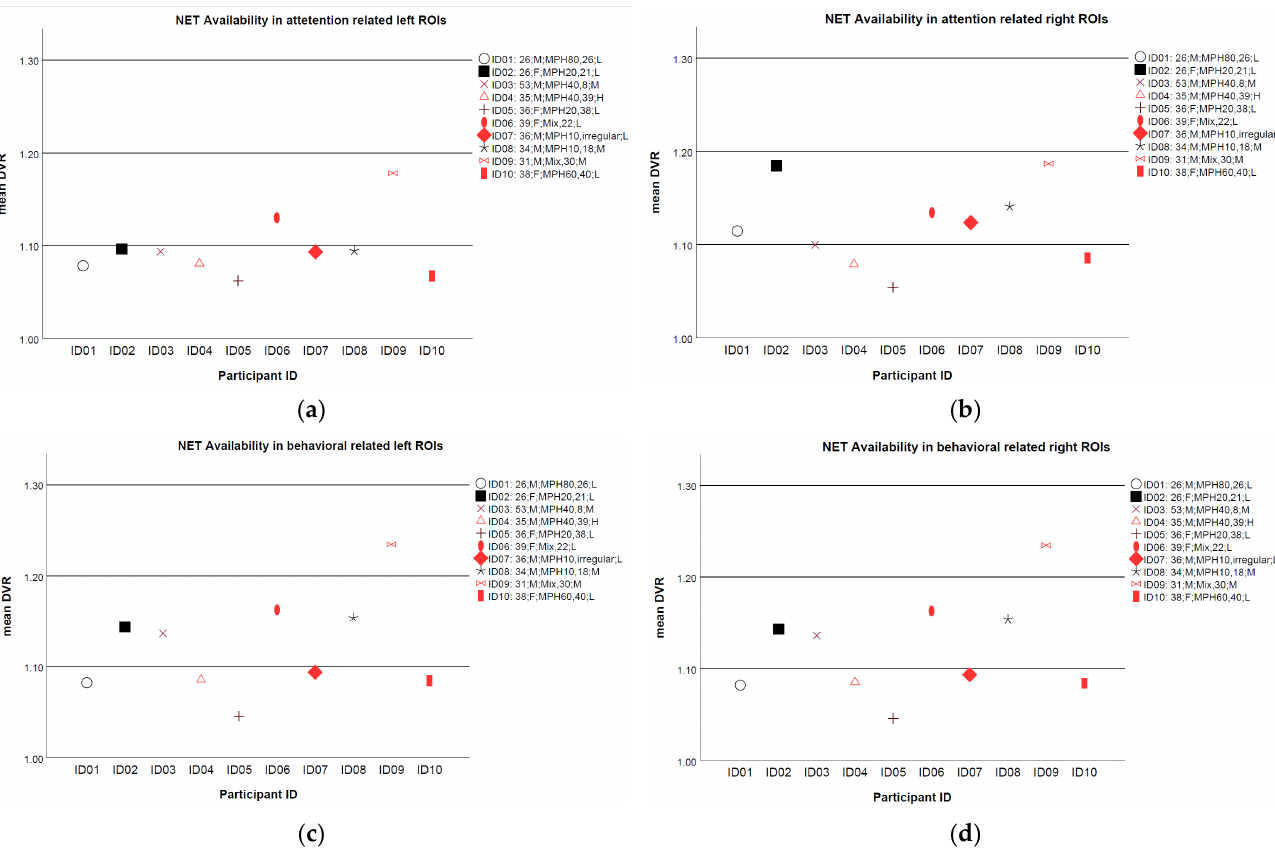
Figure 1. Mean distribution volume ratios (DVRs) of NET availability for each participant in ( a ) attention-related left selected regions of interest (ROIs); ( b ) attention-related right ROIs; ( c ) behavior-related left ROIs; and ( d ) behavior-related right ROIs. Participants with some improvements in CAARS DSM-Global raw scores are marked as red. Participants with diagnosed comorbidities are indicated by filled signs. Note: description in the legend represents, in turn, participant ID, age, sex, medication name, duration in months and level of social limitations. L, low limitations; M; moderate limitation level; H, significant limitations.